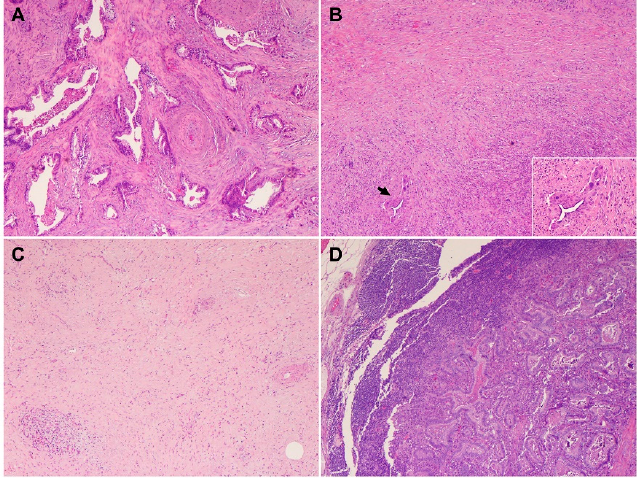
Figure 4. Heterogeneous response of PDAC to neoadjuvant therapy (hematoxylin and eosin stain). ( A , B ) Representative micrographs showing a PDAC with an area of minimal response ( A ) and near complete response in other areas ( B ); ( C , D ) representative micrographs showing a PDAC with complete response in primary tumor ( C ) but minimal response in the metastatic PDAC in the regional lymph node ( D ).